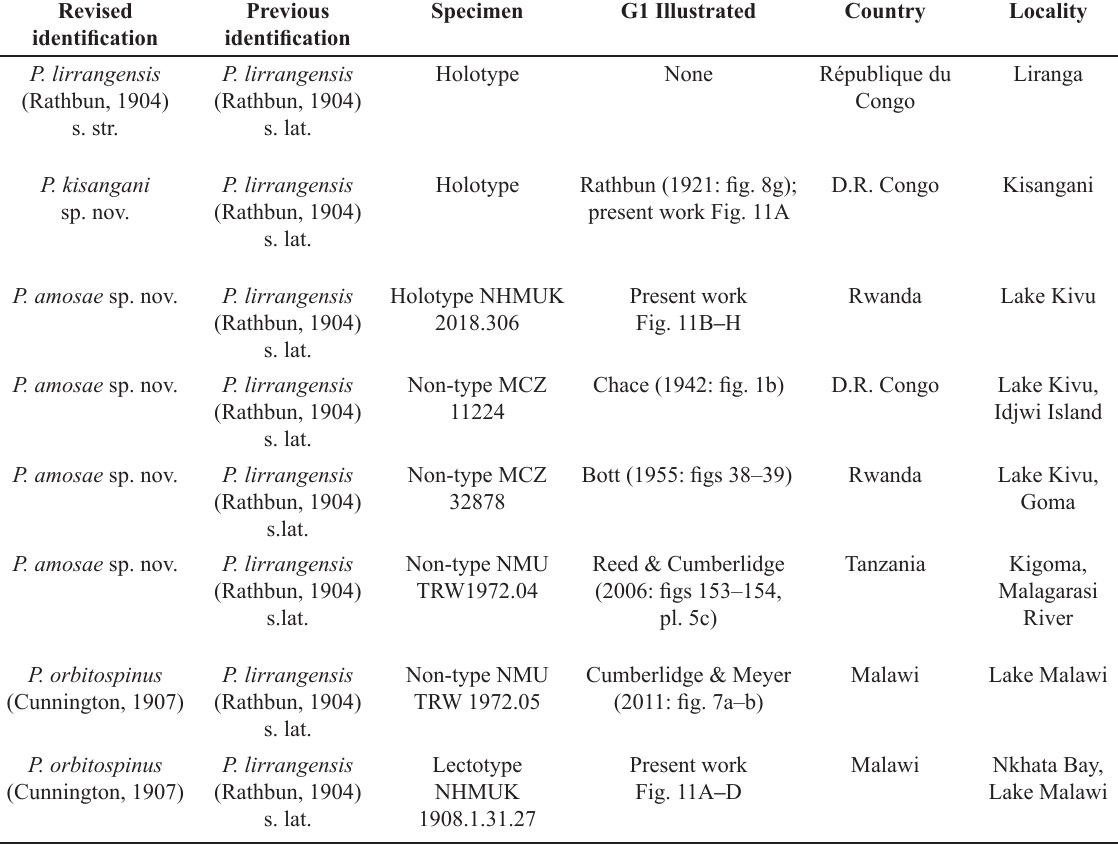
Table 1. History of the description of the first gonopod (G1) of specimens of Potamonautes lirrangensis (Rathbun, 1904) s. lat. with the revised identifications in the present